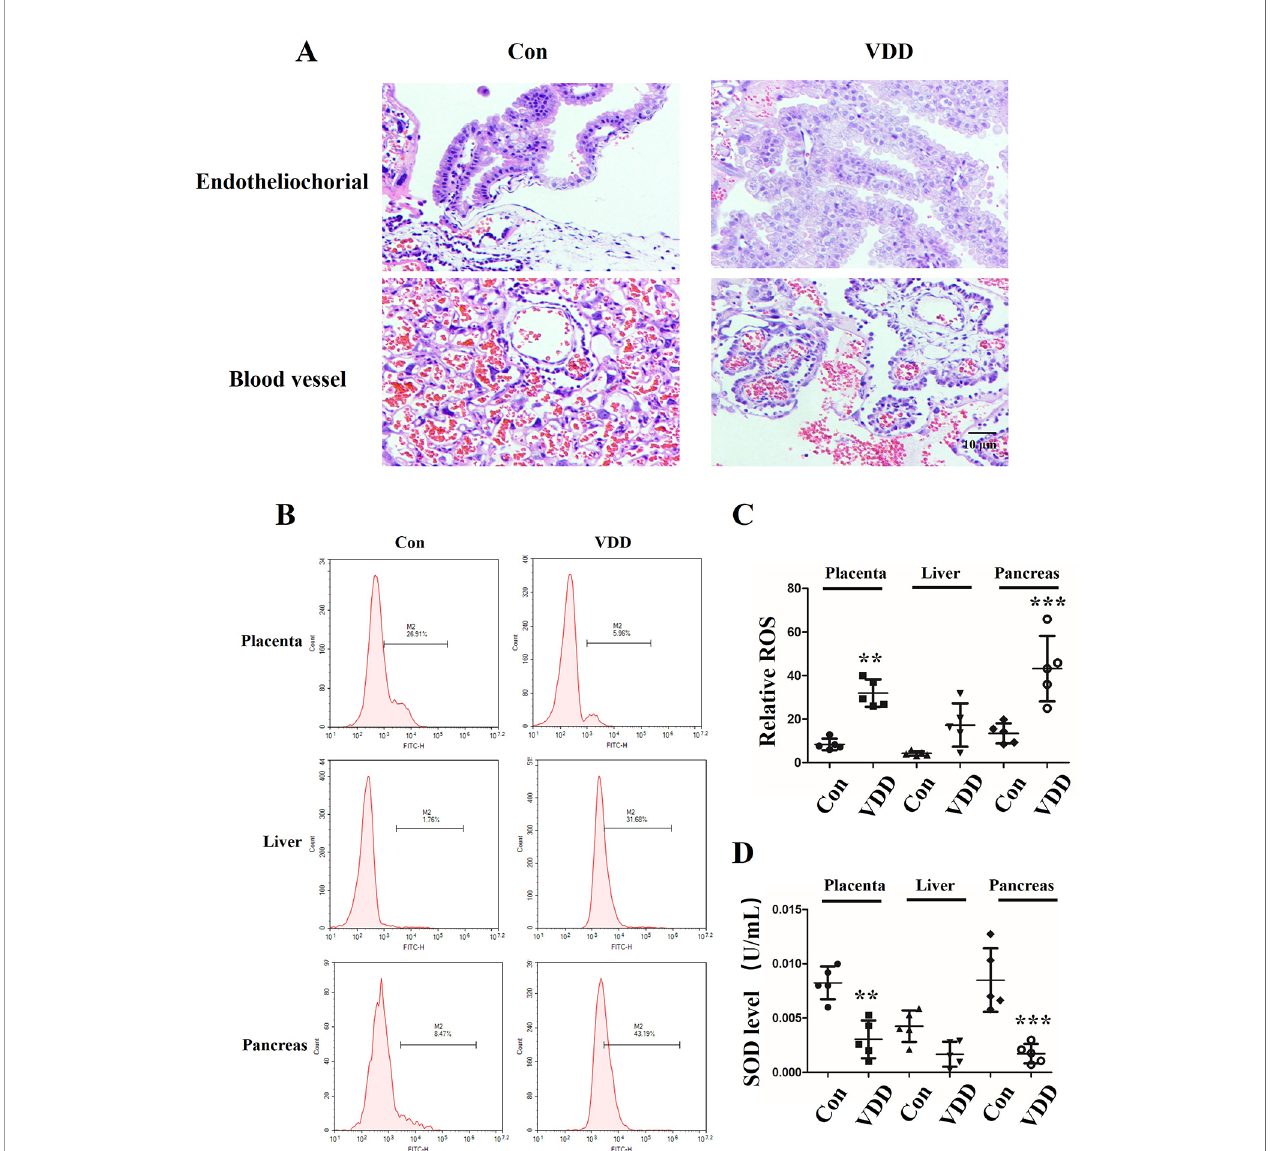
FIGURE 2 | Structure change of the placenta and ROS accumulation under maternal vitamin D de fi ciency status. (A) HE staining for blood vessel numbers and amniotic epithelium information in SD rat placenta on gestation day 21. (B) The ROS levels in maternal placenta, liver, and pancreas were assessed by fl ow cytometry using the CM-H2DCFDA fl uorescence probe. (C) The percentage of fl uorescence intensity was calculated as relative ROS level in maternal placenta, liver, and pancreas. (D) The SOD levels were detected in the maternal in maternal placenta, liver, and pancreas. The data are expressed as the means ± SD of at least three independent experiments. n = 5 rats per group. ** P < 0.01, *** P < 0.001 represents the comparisons between maternal 25-hydroxyvitamin D de fi ciency group (VDD) and normal control group (Con). Normal group, Con; maternal 25-hydroxyvitamin D de fi ciency group, VDD; week,